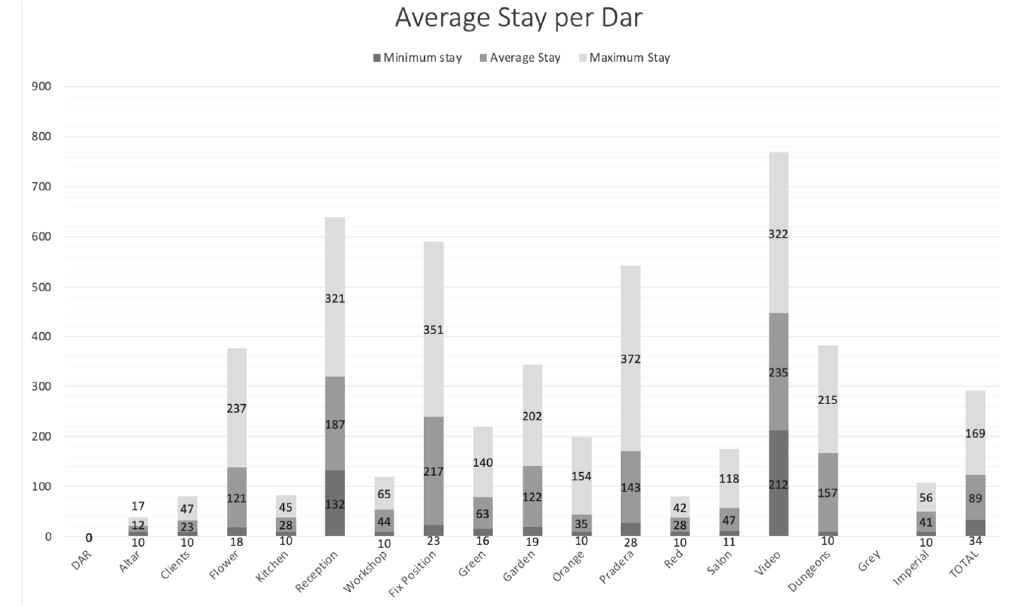
Figure 10. Graph showing average stay per DAR in